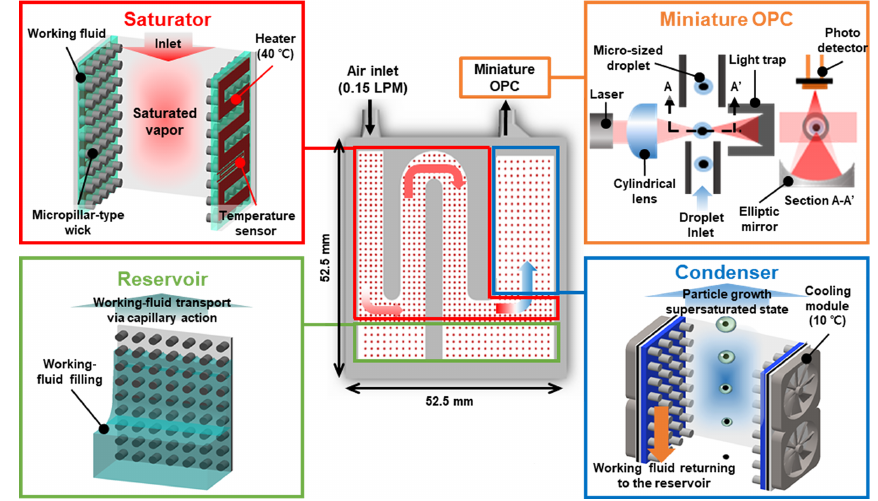
Figure 1. Schematic illustration of the MEMS-based CPC. Our system consists of four parts: the reservoir, saturator, condenser, and miniature OPC. The reservoir supplies the working fluid to the saturator via capillary action by the micropillar-type wick. The saturator heats the working fluid to generate saturated vapor. The saturated air becomes supersaturated when cooled by the condenser. UFPs grow into micro- sized droplets in the condenser. They are counted by the miniature